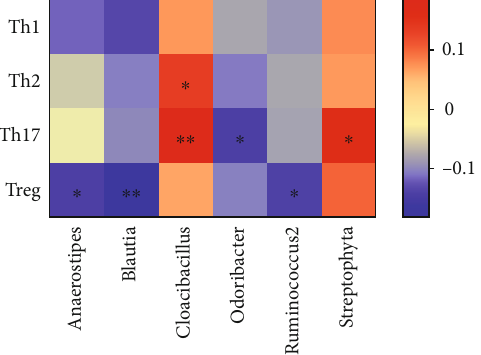
Figure 6: A heat map shows the correlation between di ff erent gut microbial species and CD4 + T lymphocyte subpopulations. Colors indicate the Spearman rank correlation ( ∗∗ P < 0 : 01 , ∗ P < 0 : 05 ).